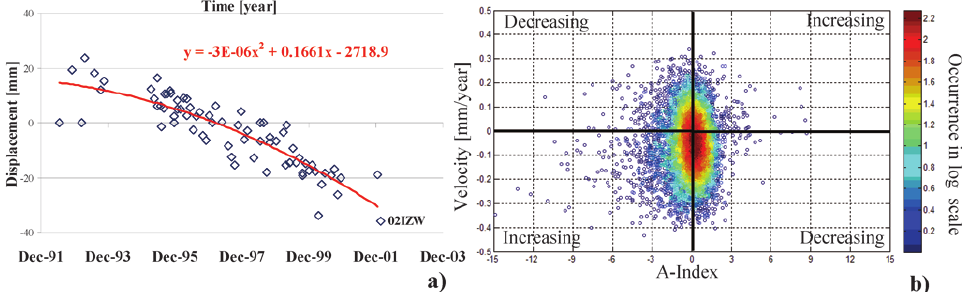
Fig. 7. (a) A-index value represents the coefficient of x squared in the second order polynomial equation fitting the time series; (b) A-index vs. LOS-velocity diagram for the ERS ascending (45 images acquired from September 1992–September 2000) PSI data; the colour bar shows the occurrence in log-scale.